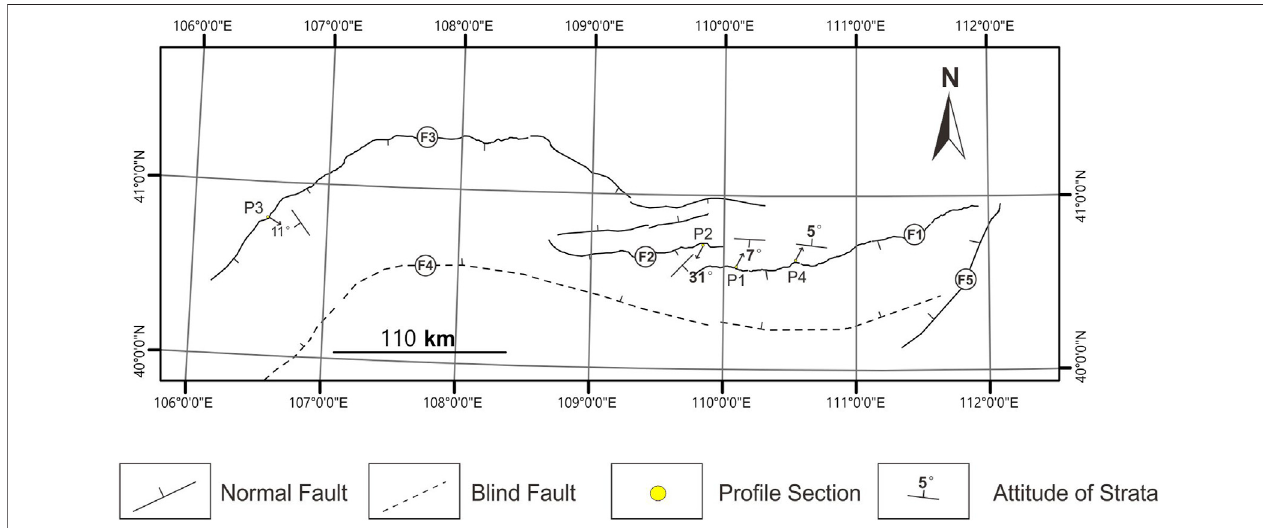
FIGURE 7 | The position of the study section and the fault. P1: Haolaigou Section; P2: Bianqianghao Section; P3: Huhesala Section; P4: Hazigai Section. F1: DaqingshanFault;F2:WlashanFault;F3:Langshan-SeertengshanFault;F4:NorthOrdosFault;F5:HelingeerFault.Theattitudeofstratamarkedonaboveistheattitude of the deformed strata below the unconformity surface. The attitude of P1 is the formation transition below uc1.